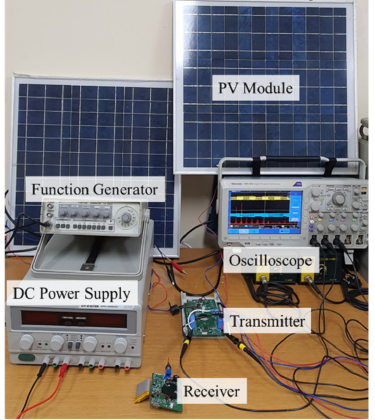
Figure 20. Devices used in the